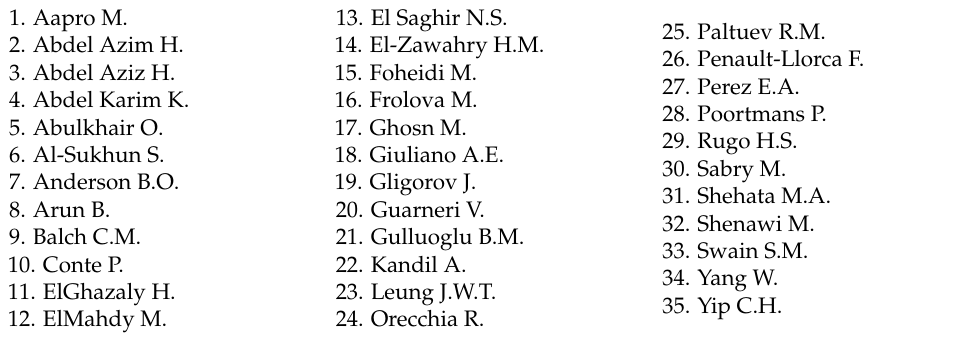
Table 1. List of panellists